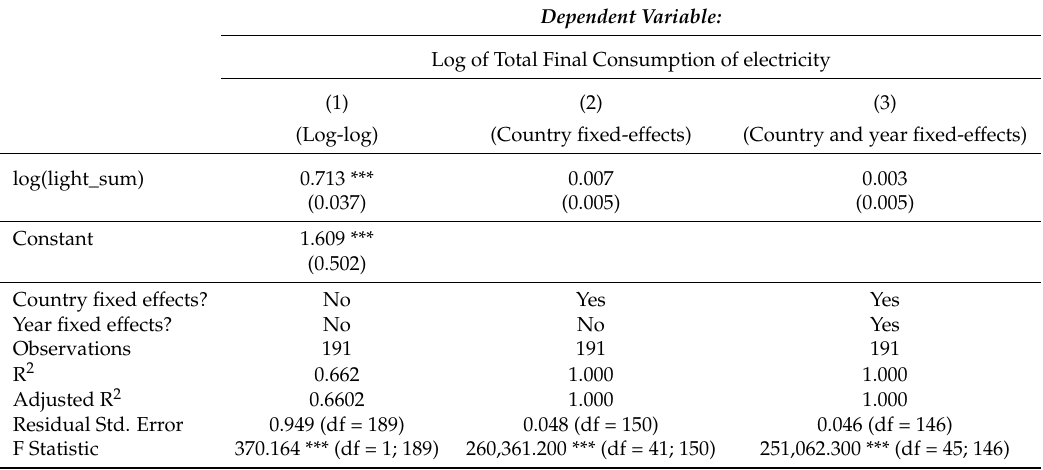
Table A9. Regression for RESIDENT—High-income